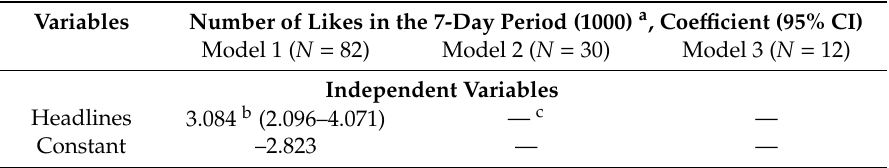
Table 7. Simple linear regression